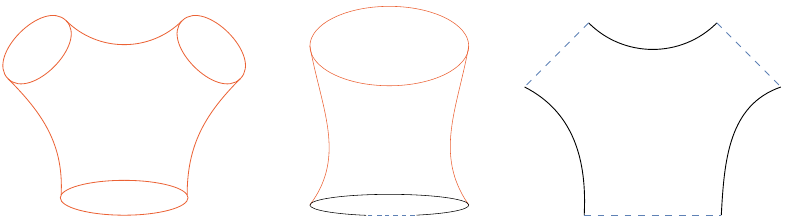
Figure 1 . The three elementary “legos” out of which one can construct a BCFT 2 correlation function on a Riemann surface with open boundaries: (i) bulk OPE structure constant , (ii) bulk-to- boundary structure constant and (iii) boundary structure constant. The solid orange lines represent points on the bulk surface, whereas solid black lines represent a conformal boundary. Local bulk operator insertions are depicted as orange circles, while local boundary operator insertions as dashed blue